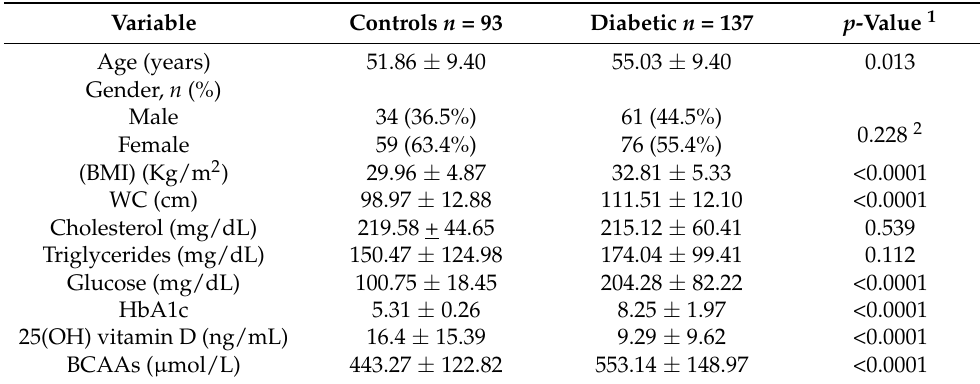
Table 1. Baseline variables of the study